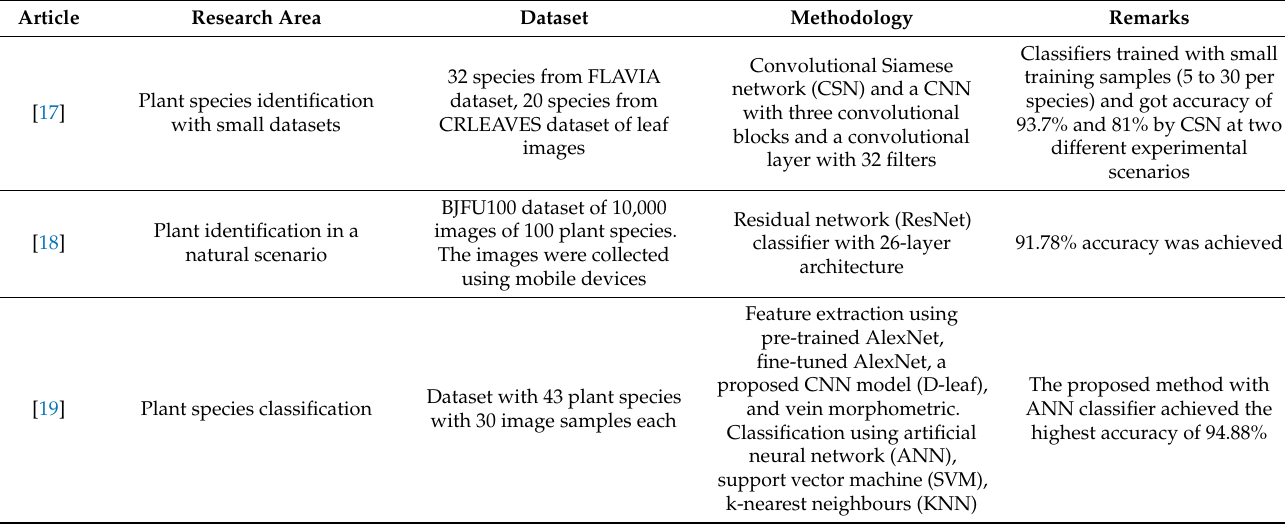
Table 1. State-of-the-art